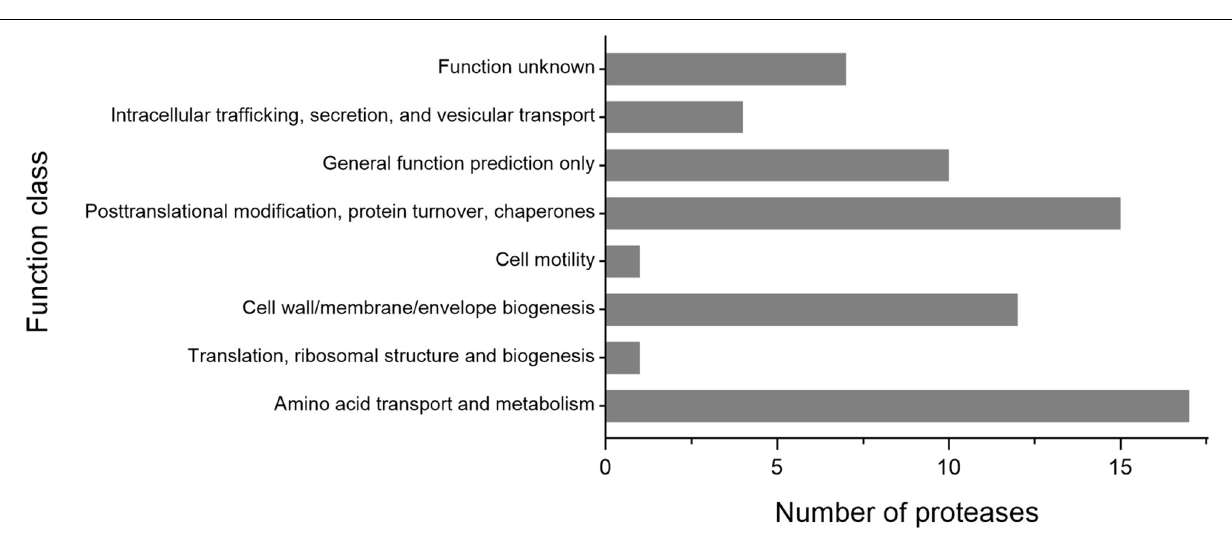
FIGURE 5 | Number of the intracellular proteases of strain 1A02591 in the function classes based on COG